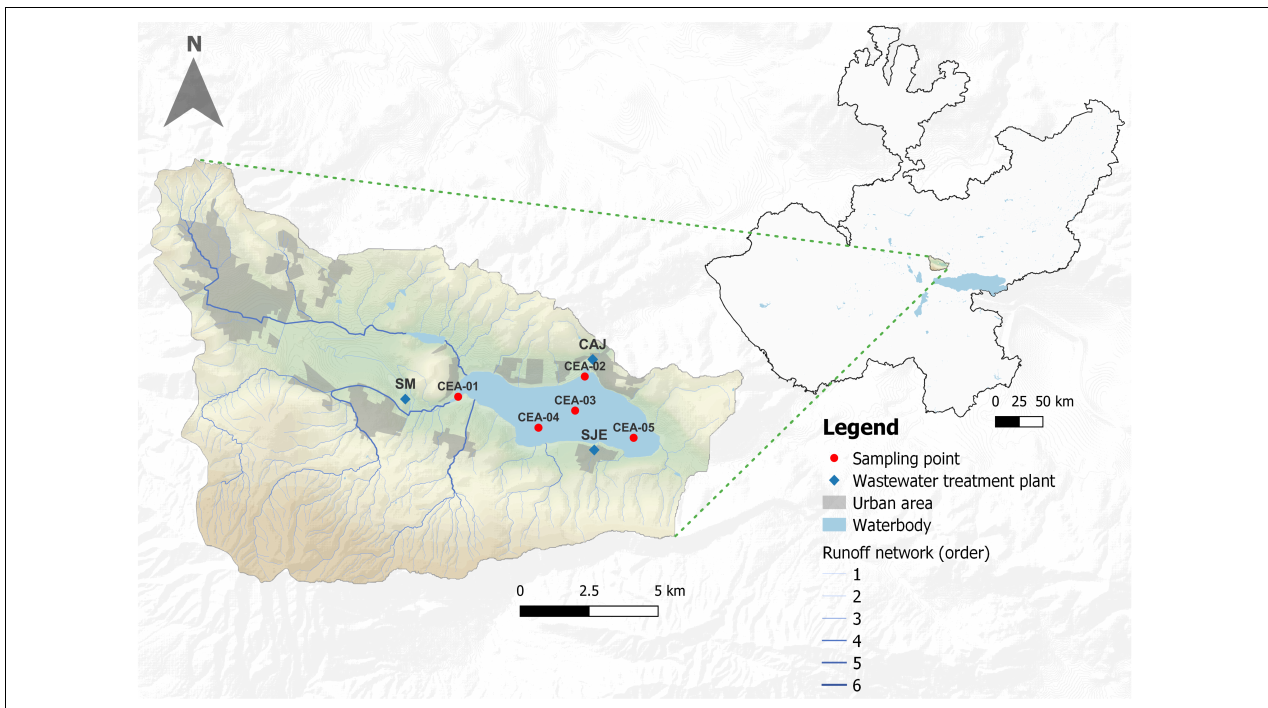
FIGURE 1 | Location of the sampling points in Lake